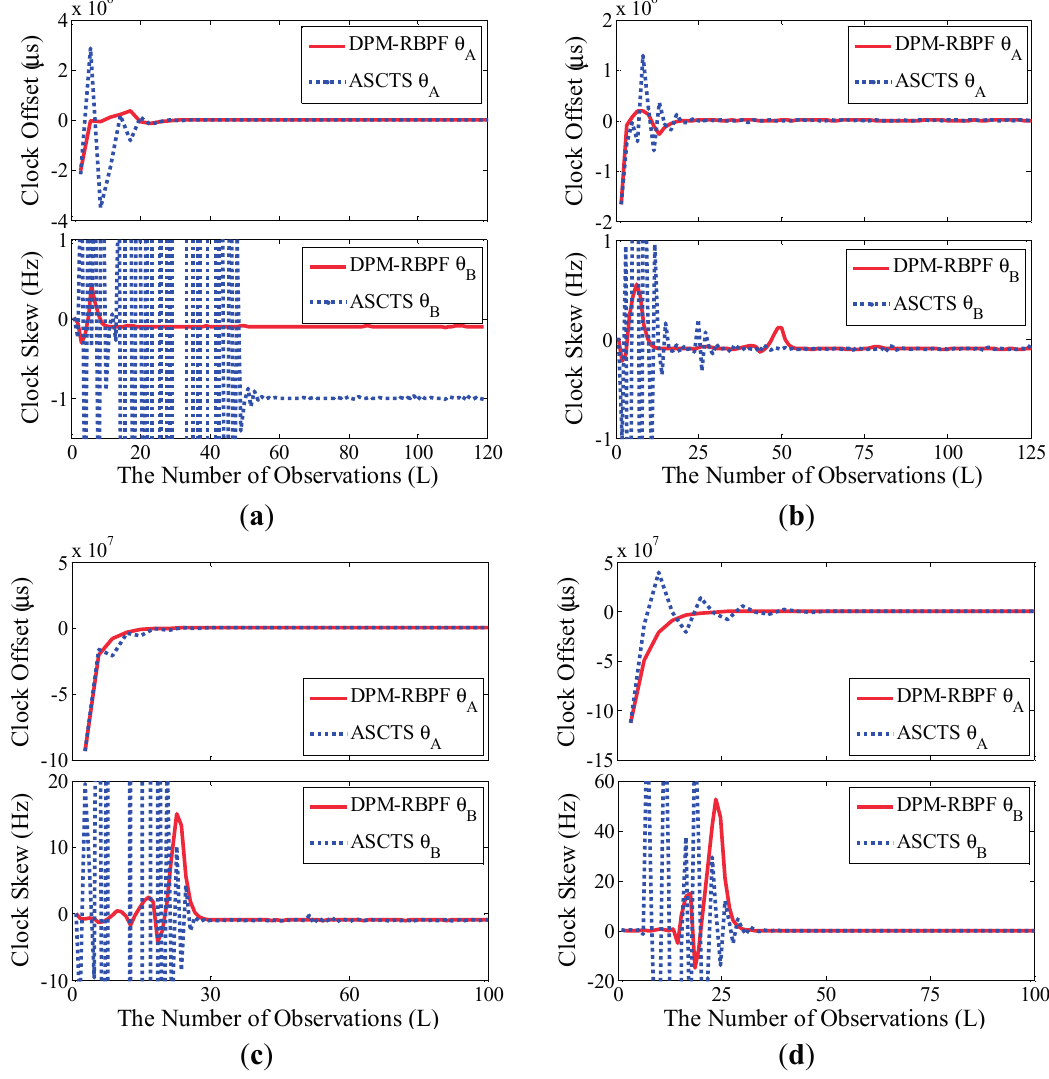
Figure 7. Tracking curves of ASCTS and DPM-RBPF (time interval 5 s). ( a ) Node A; ( b ) Node B; ( c ) Node C; ( d ) Node